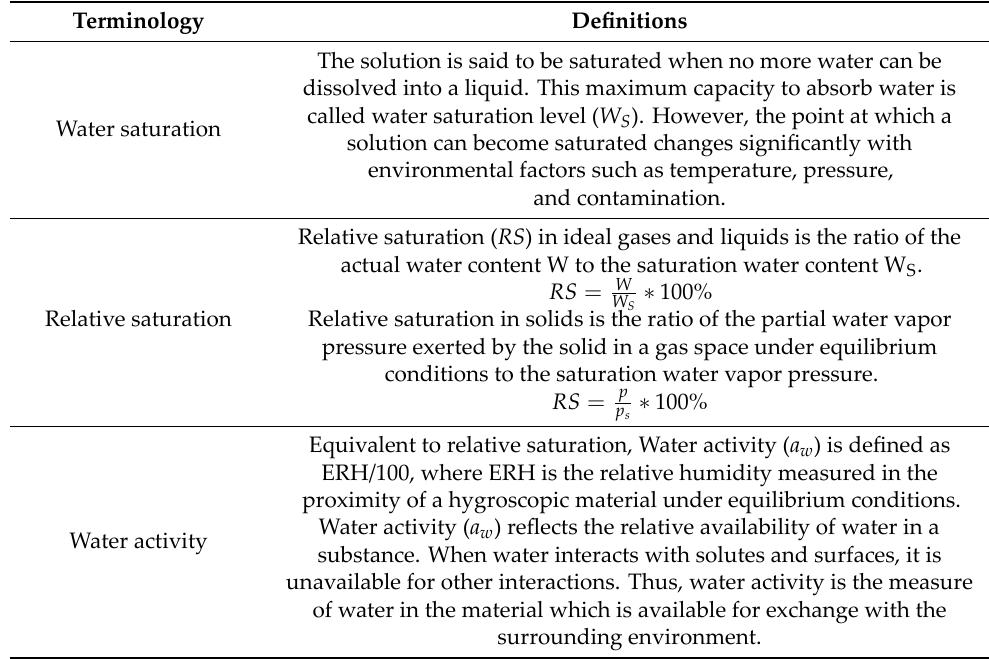
Table 2. Common Terminologies for Saturated Meter